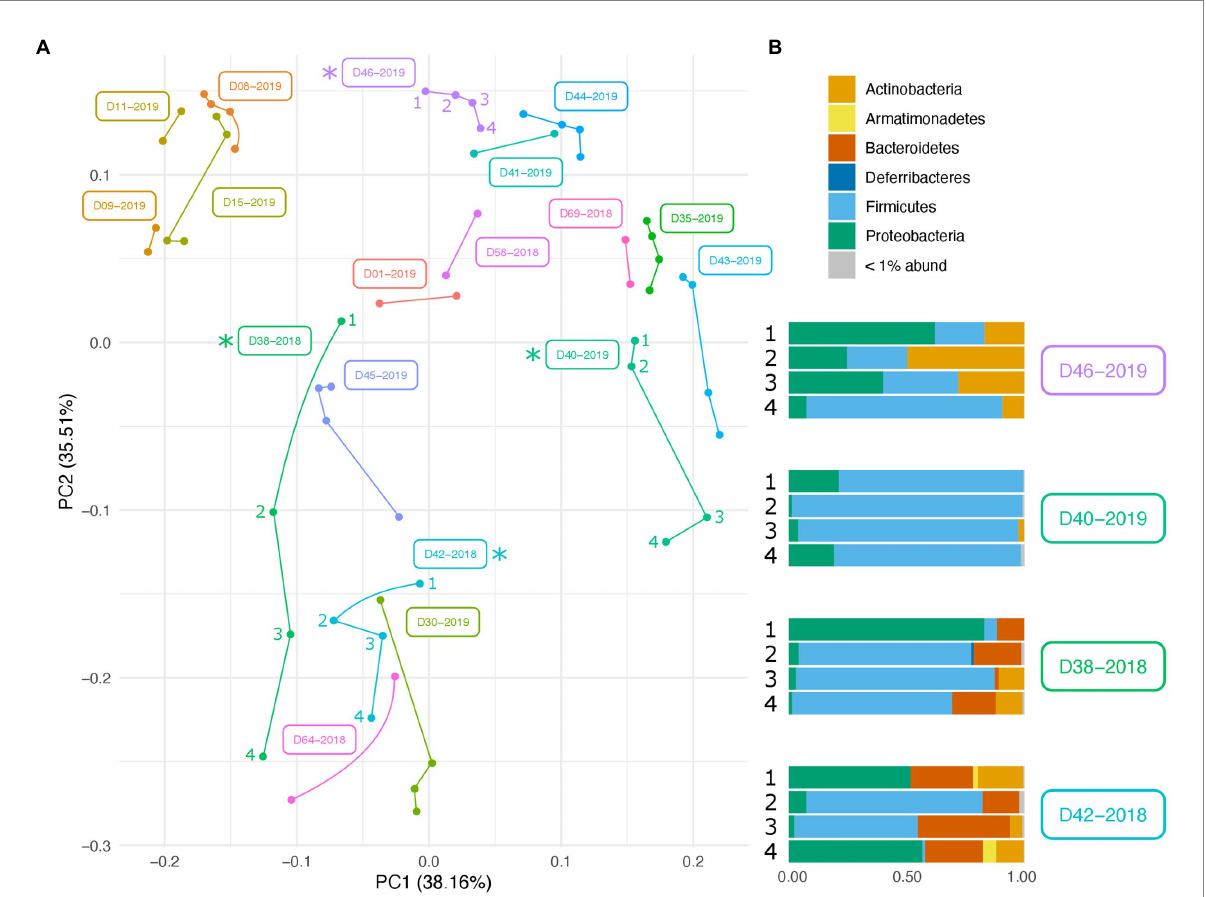
FIGURE 3 Variation in microbial community across swabs taken from the same individual. (A) PCA plot of PhILR transformed beta diversity metrics. Individual swabs are represented as points. Swabs taken from the same individual are connected by a line. (B) Taxonomic composition differences across swabs taken from the same individual at the same sampling point. Corresponding samples are indicated on the PCA plot with an